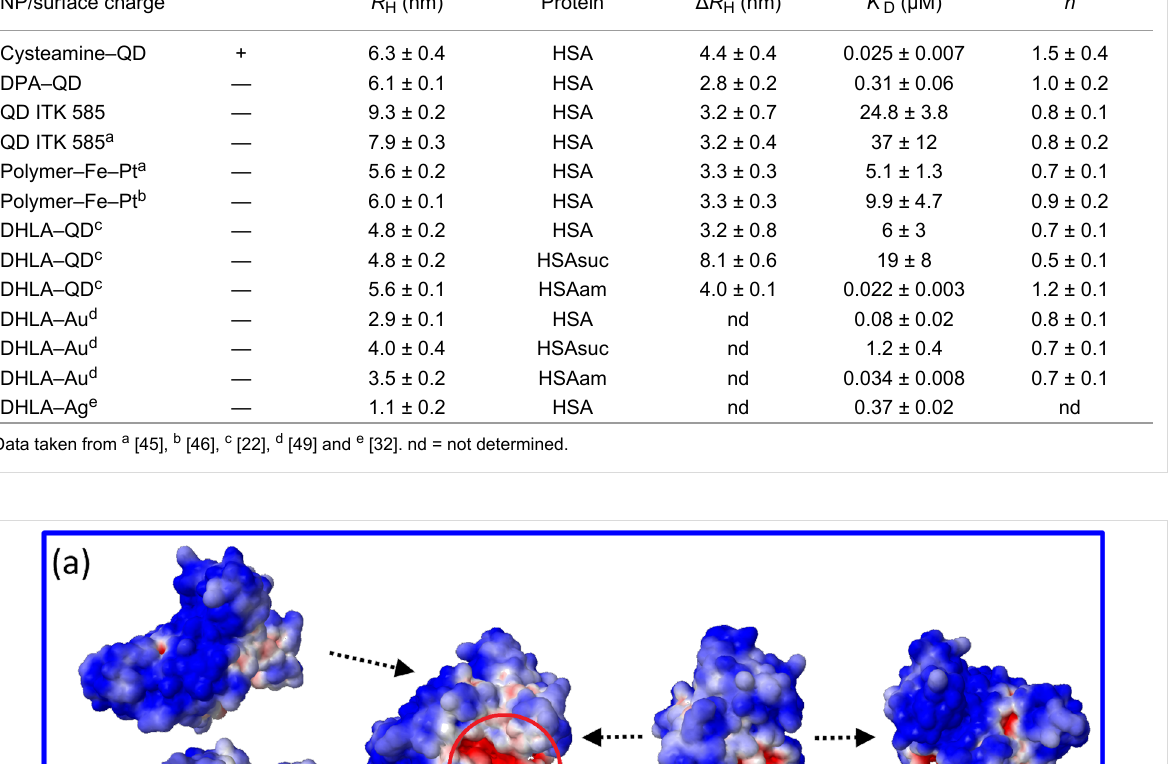
Table 2: Parameters describing the adsorption of HSA and chemically modified HSA onto NPs with different surface coatings. NP/surface charge